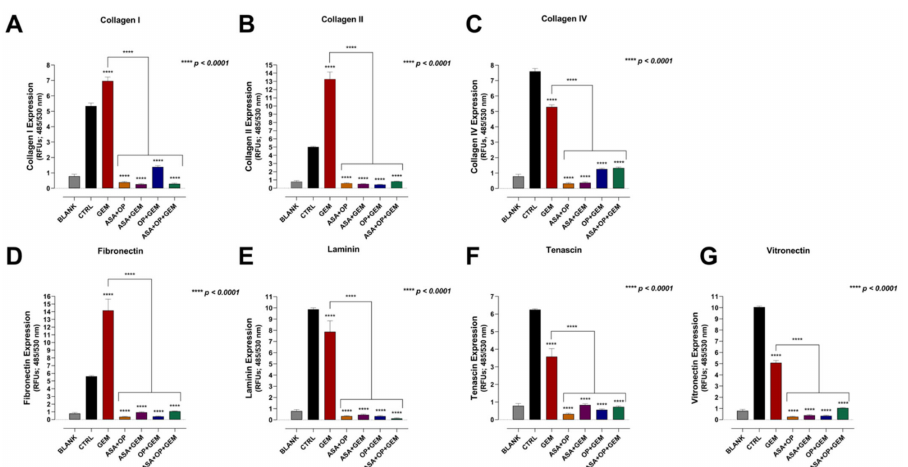
Figure 7. ASA, OP, GEM, and their combination alter the expression of adhesion markers in PANC-1 cells. PANC-1 cells were pre-treated with ASA (4 mM), OP (4.7 mM), GEM (0.338 µ M), or their combination for seven days. Cells were collected, resuspended, and adhered to coated substrates to capture adherent cells. Adherent cells were lysed and dyed, allowed to incubate, and read with a fluorescence plate reader. Graphs show expression of ( A ) collagen I, ( B ) collagen II, ( C ) collagen IV, ( D ) fibronectin, ( E ) laminin, ( F ) tenascin, and ( G ) vitronectin as relative fluorescent units (RFUs) (ex 450 nm; em 530 nm). Data are presented as the mean ± SEM of 3 independent experiments performed in triplicates. Significance is shown compared to the CTRL, unless otherwise indicated, using the one-way ANOVA Fisher test comparisons with 95% confidence with indicated asterisks for statistical significance. Abbreviations: ASA, aspirin; OP, oseltamivir phosphate; GEM, gemcitabine; RFU, relative fluorescent unit; SEM, standard error of the mean; CTRL,